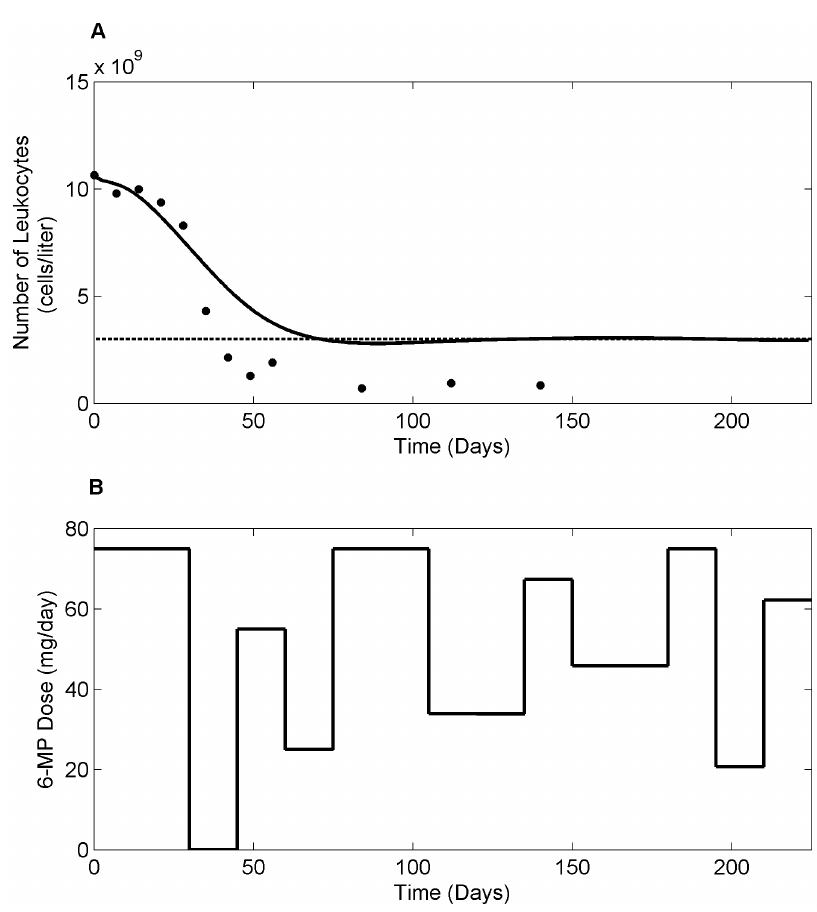
Figure 13. Optimal dosing based on leukocyte count as target. A. Evolution of leukocyte count in response to optimum 6-MP dosing. Dashed line represents critical leukocyte level and solid dots represent clinical data for an average patient. B. Optimum 6-MP dosing profile predicted by NMPC. The standard daily 6-MP dosing is 75 mg/day.